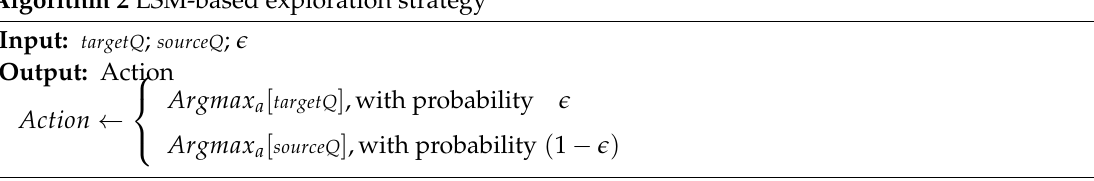
Algorithm 2 LSM-based exploration